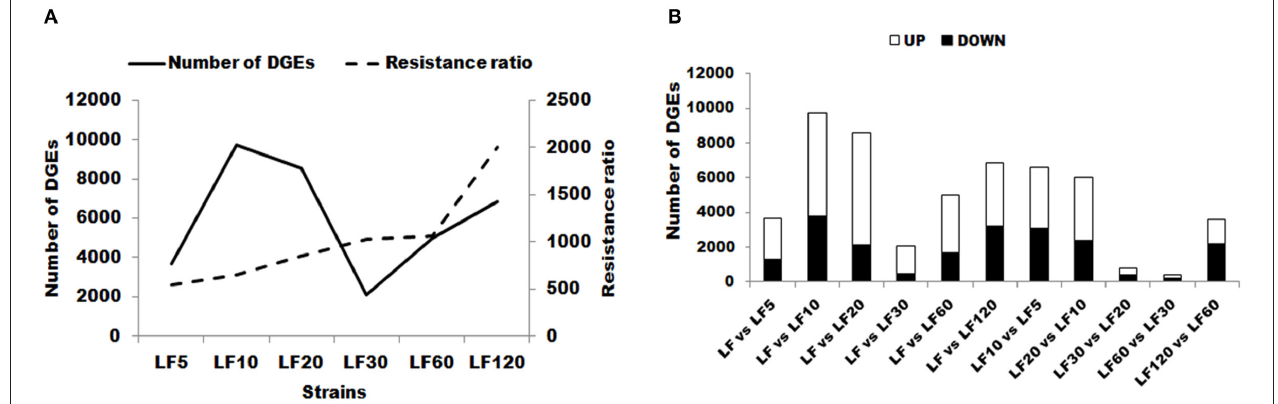
Frontiers in Physiology |